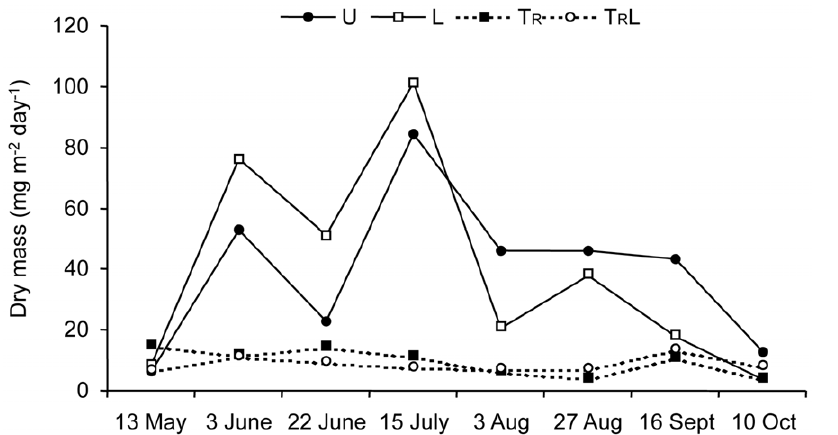
Figure 3. Flux of falling invertebrates. Changes in the flux of falling terrestrial invertebrates (mean dry mass, mg m 2 2 day 2 1 ) in unmanipulated (U), light (L), terrestrial invertebrate reduction (T R ) ), terrestrial invertebrate reduction 6 light (T R L) treatments throughout the study. Error bars have been omitted for clarity.